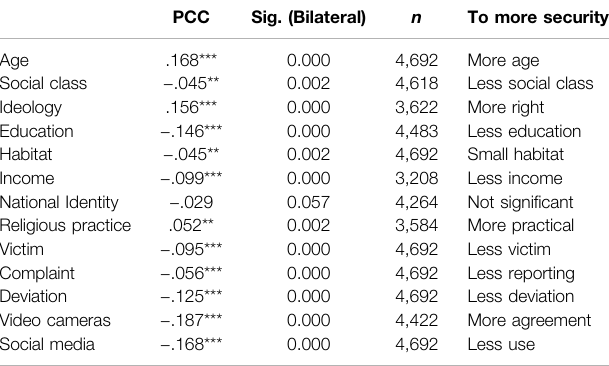
TABLE 3 | Descriptive and sociodemographic pro fi les. TABLE 4 | Correlation between Freedom-Security and continuous